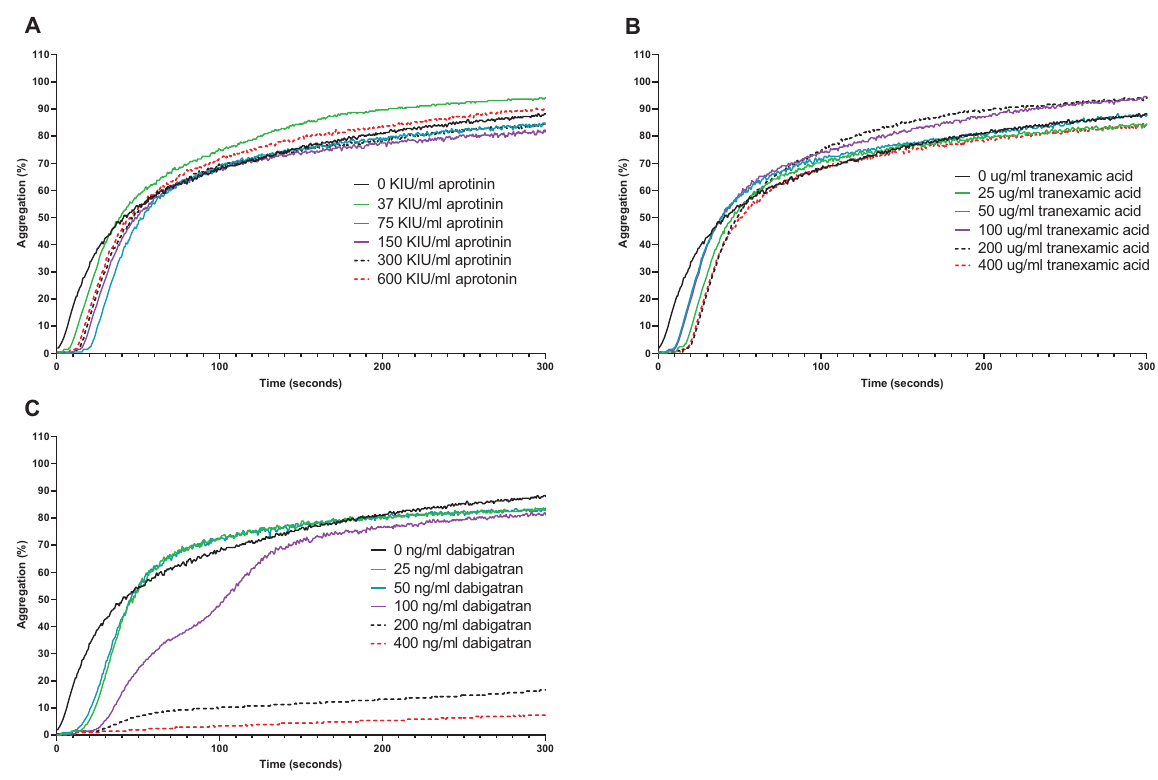
Fig. 8 Effects of aprotinin and TXA on thrombin-induced platelet aggregation. Aprotinin (panel A), tranexamic acid (panel B), or dabigatran (panel C) were added in increasing concentrations to washed human platelets after which platelet aggregation was initiated by addition of 1 U/ml of thrombin. Shown is a representative example of experiments performed with three different platelet donors.